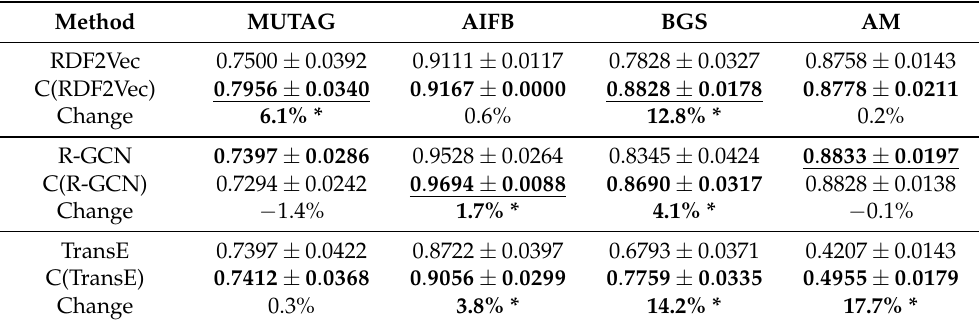
Table 2. Results of pairwise comparison between our strategy and baseline embedding methods as measured by accuracy (mean ± standard deviation) obtained on testing entities for each dataset. Asterisk (*) indicates superior performance as per Student’s t -test at a 0.05 level of significance. Underline indicates top performance on the dataset, regardless of the baseline method. Method